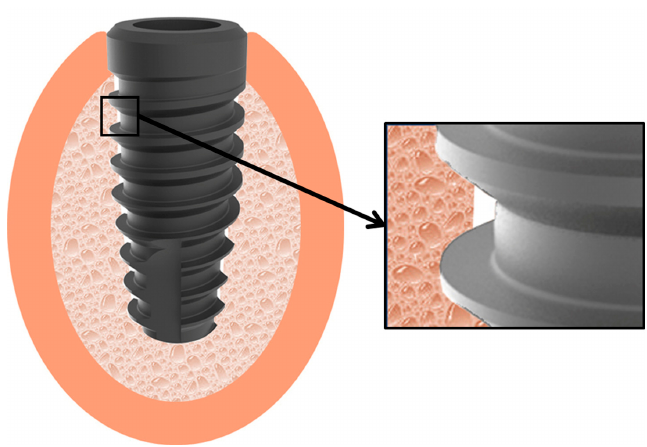
Figure 1. Schematic image of the space created after drilling to generate the healing chamber inside of the threads to facilitate the osseointegration.